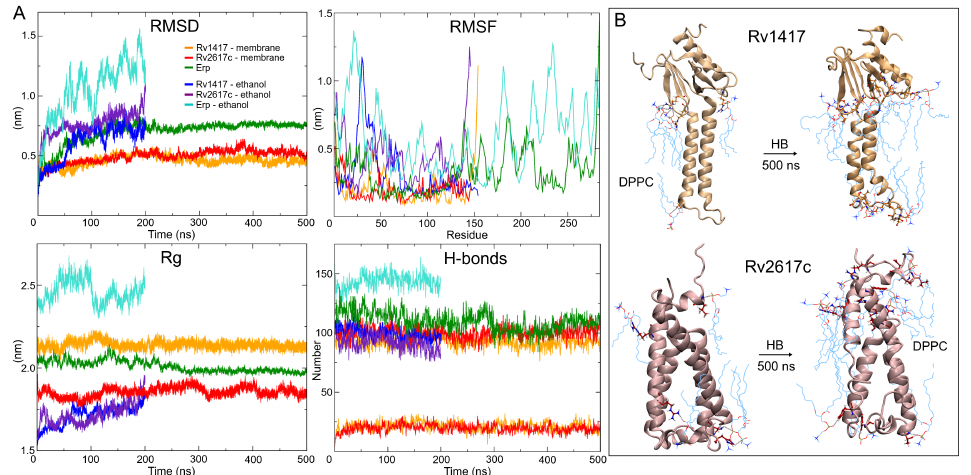
Figure 3. MD results. ( A ) Stability descriptors of the protein systems. ( B ) Intermolecular hydrogen bonds found at the initial and final frames of MD trajectories. The DPPC membrane molecules are depicted by cyan lines and protein residues by CPK representation.